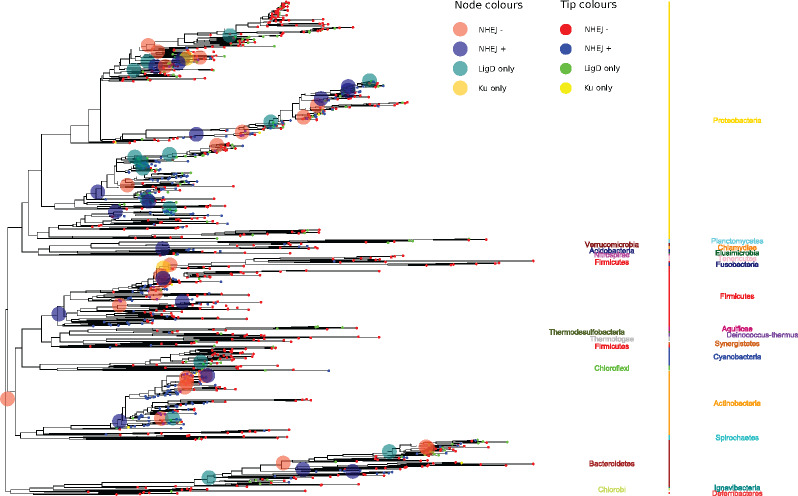
NHEJ was gained and lost multiple times through evolution. A trace of the evolutionary history of the two-component NHEJ system across 969 bacteria. These species were included such that each genus was chosen once for each NHEJ state (see Phylogenetic Tree Reconstruction section for further details). The phylum names arranged on either sides of the vertical bars are for representational purposes only. The tip and node labels are colored according to the NHEJ states—red: NHEJ−; yellow: Ku only; green: LigD only; blue: NHEJ+ (conventional and nonconventional). NHEJ state for nodes is shown only when the posterior probability support is >70%; interpreted as change in NHEJ state at that node as compared with shallower phylogenetic depths.